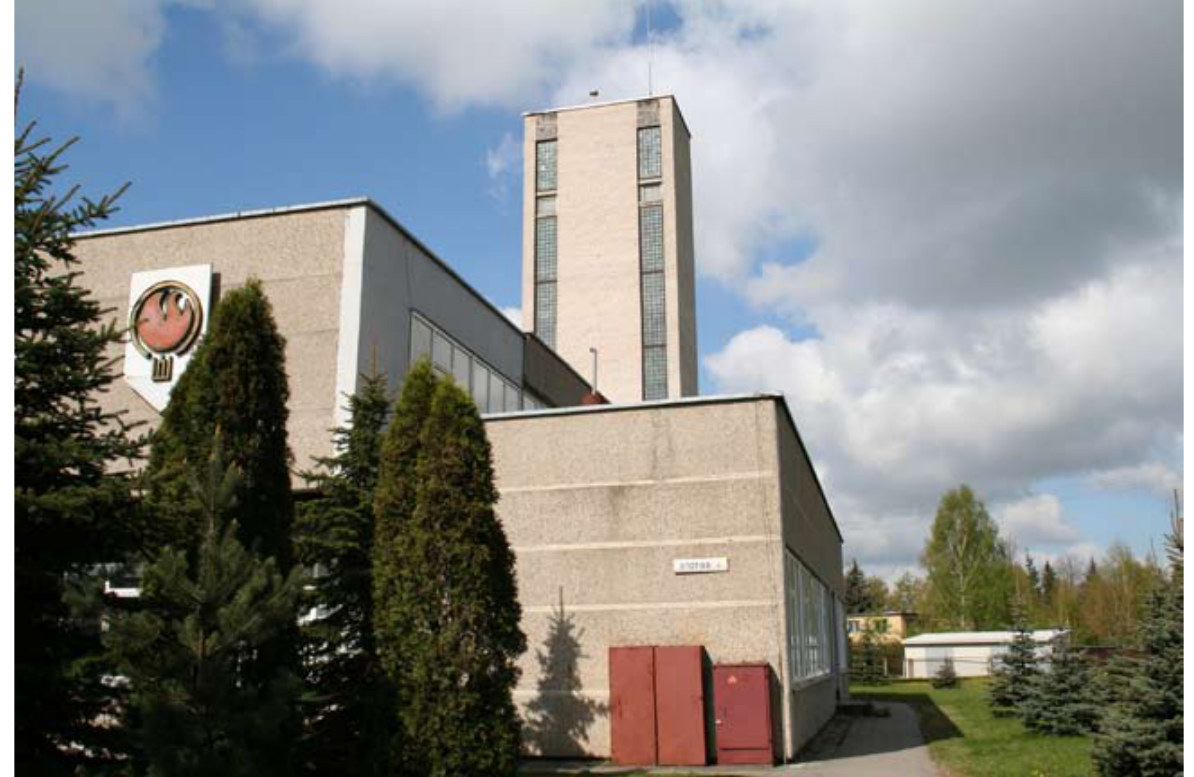
Fig. 4 . GPS antenna on the roof of fire station tower